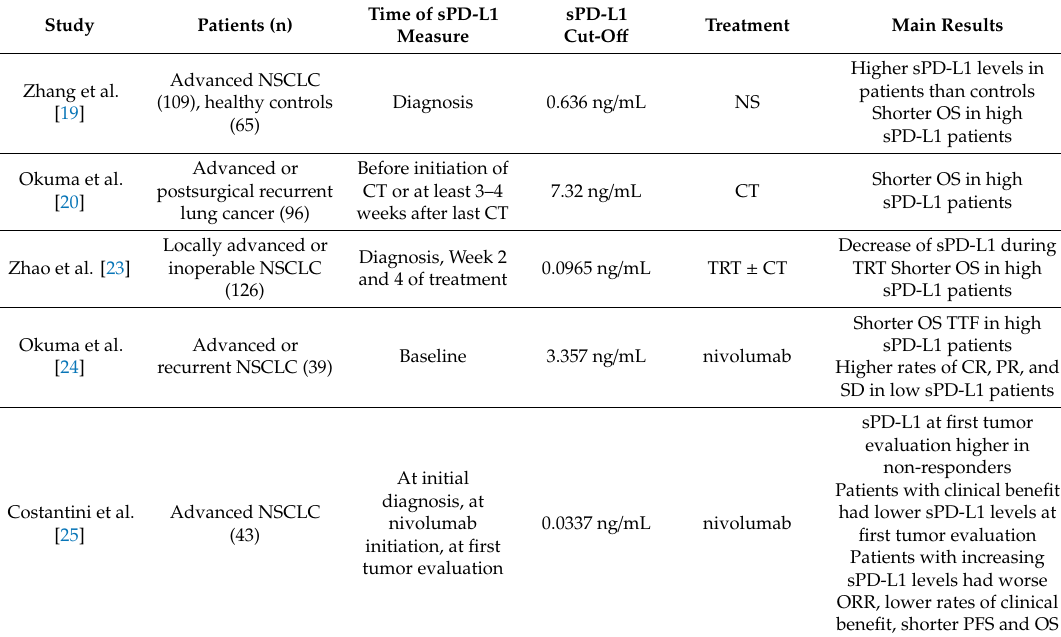
Table 1. Comparison of the di ff erent studies testing soluble programmed death-ligand 1